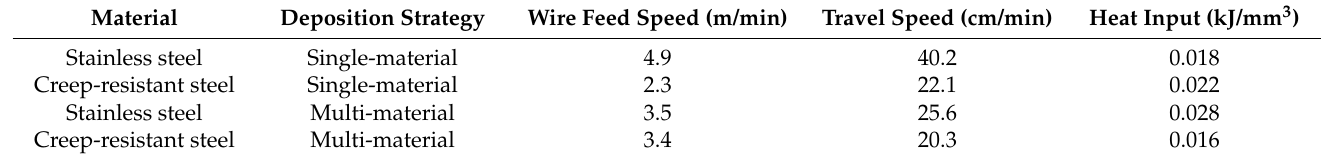
Table 2. WAAM deposition parameters and calculated heat inputs.